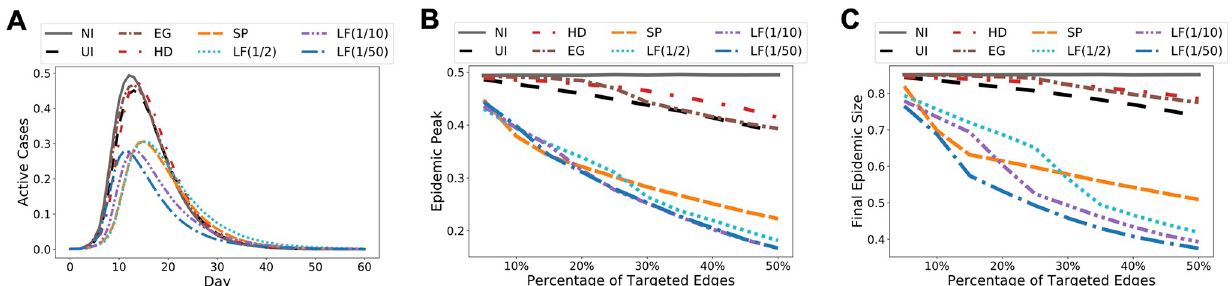
Fig 6. Simulation results for Wi-Fi Montreal. (A) Predicted epidemic curves at 25% coverage level. (B) Predicted epidemic peaks over a range of intervention coverage levels. (C) Predicted epidemic sizes over a range of intervention coverage levels.